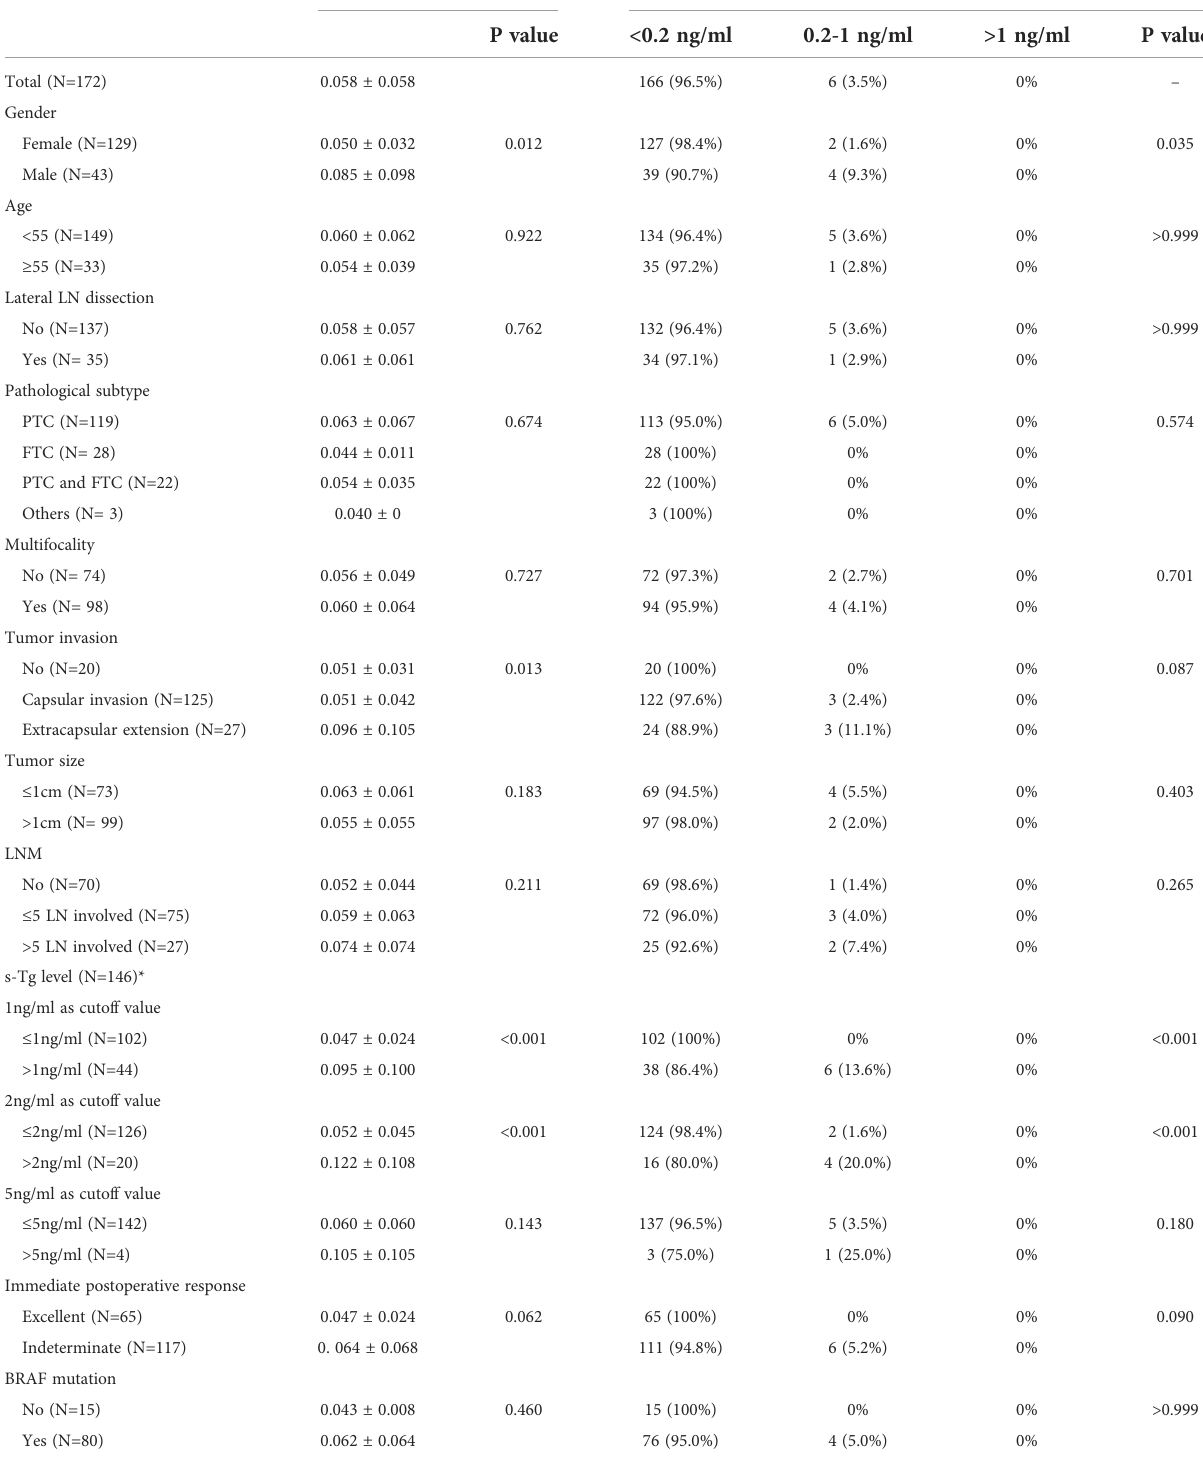
TABLE 3 u-Tg level and distribution at the last